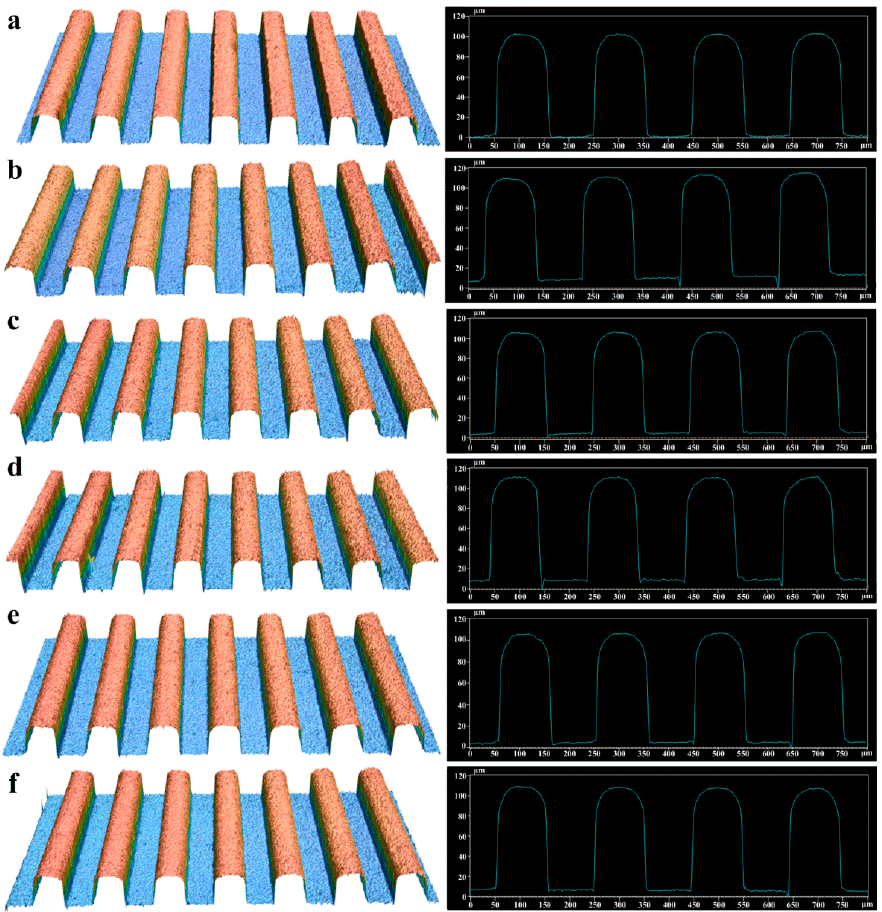
Figure 8. 3D topographies of the micro-structured polymer samples: ( a ) Sample 3; ( b ) Sample 5; ( c ) Sample 6; ( d ) Sample 11; ( e ) Sample 17; ( f ) Sample 25.